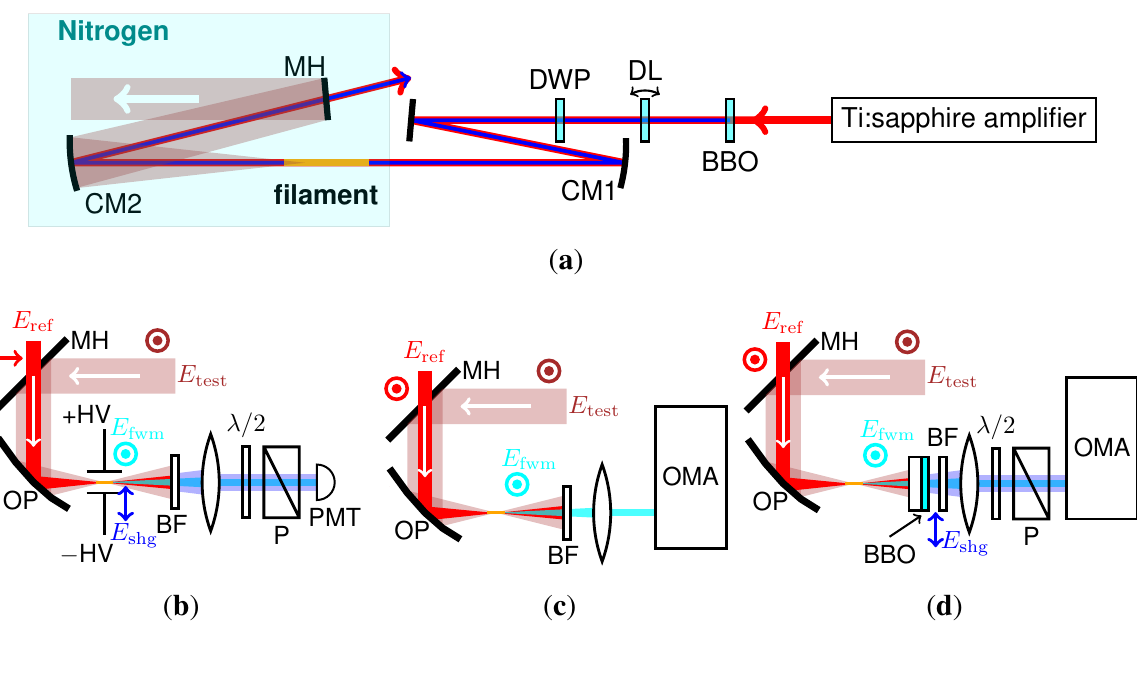
O crystal (Type 1, 2 4 O 2 4